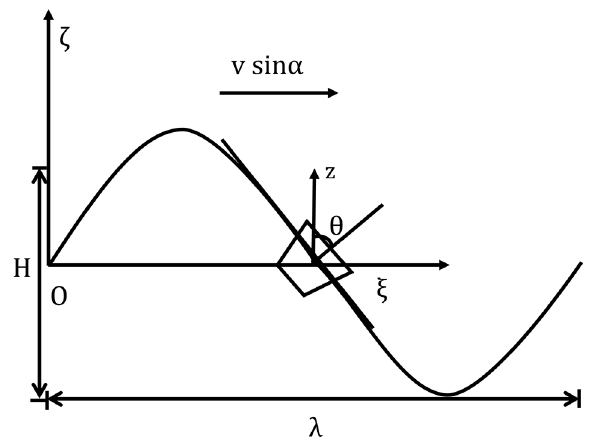
Figure 2. The coordinate diagram of floating platform.